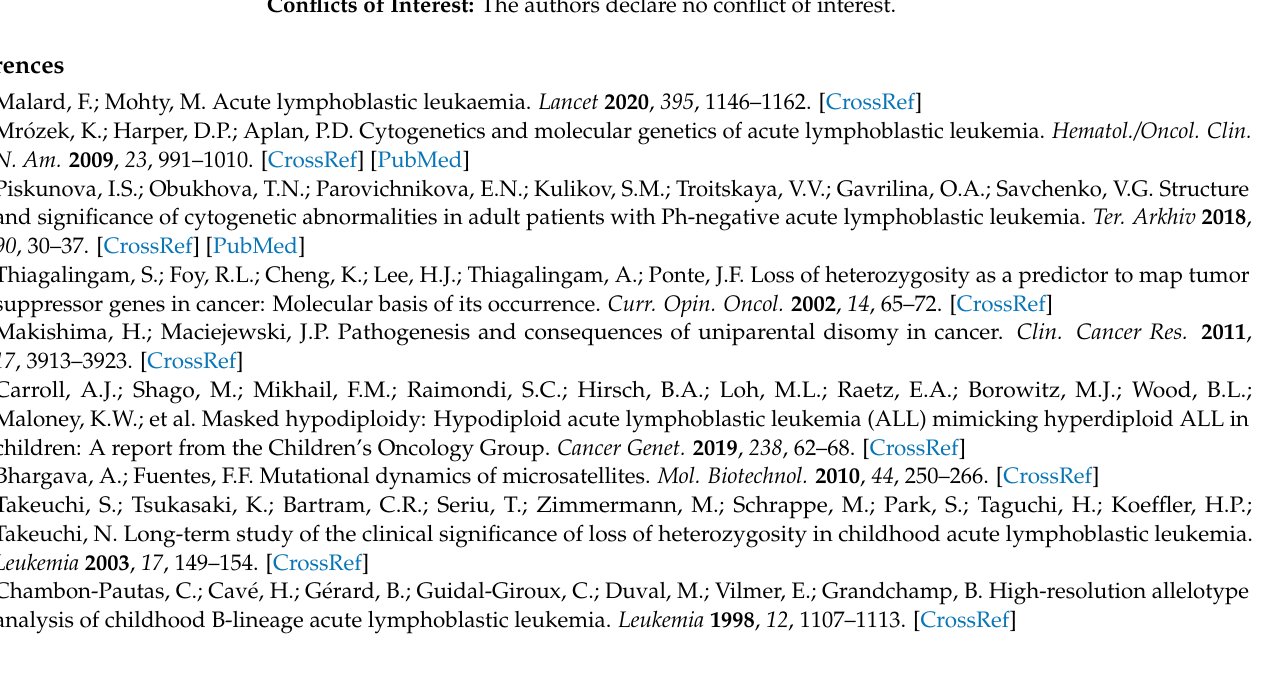
Table S2: Distribution of LOH by loci in T-ALL LOH-positive patients, Table S3: Distribution of LOH by loci in MPAL LOH-positive patients, Table S4: CMA results for patients with aberrant STR loci in tumor